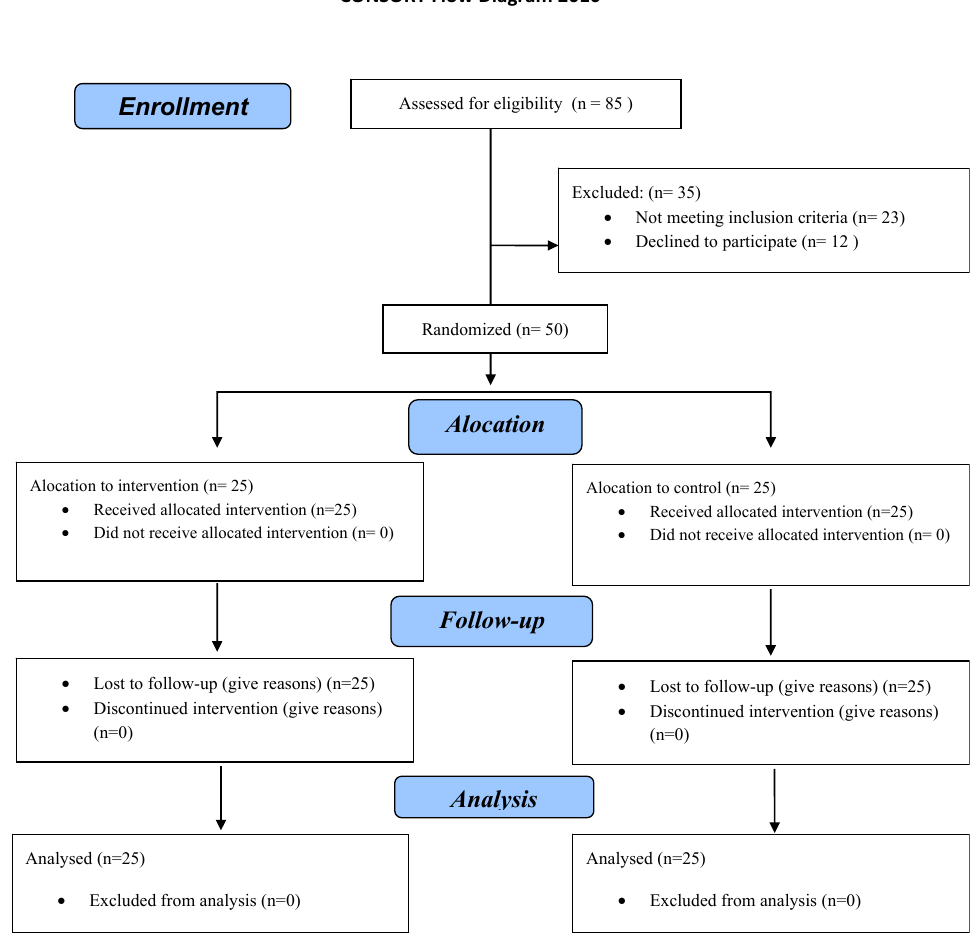
Figure 1. Follow-up of study participants according to the CONSORT 2010 flowchart.